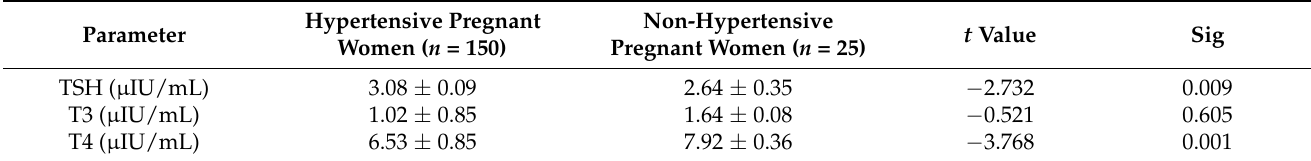
Table 4. Serum thyroid hormone levels among hypertensive pregnant women compared with non-hypertensive pregnant